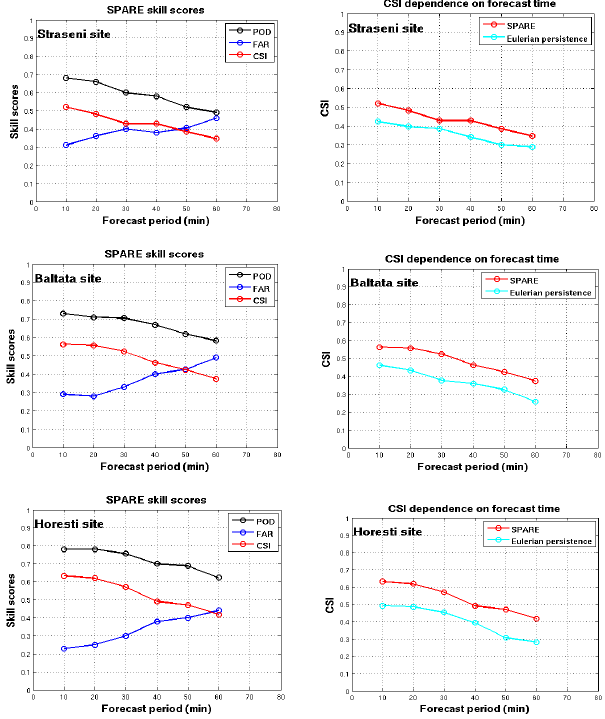
Figure 14. Left panel: SPARE skill score statistics for test set where lines represent the Fig. 14. Left panel: SPARE skill score statistics for test set where ensemble mean score values. Right panel: comparison of SPARE with Eulerian persistence lines represent the ensemble mean score values. Right panel: com- for Straseni (top), Baltata (middle) and Horesti (bottom) sites. parison of SPARE with Eulerian persistence for Straseni (top), Bal- tata (middle) and Horesti (bottom)